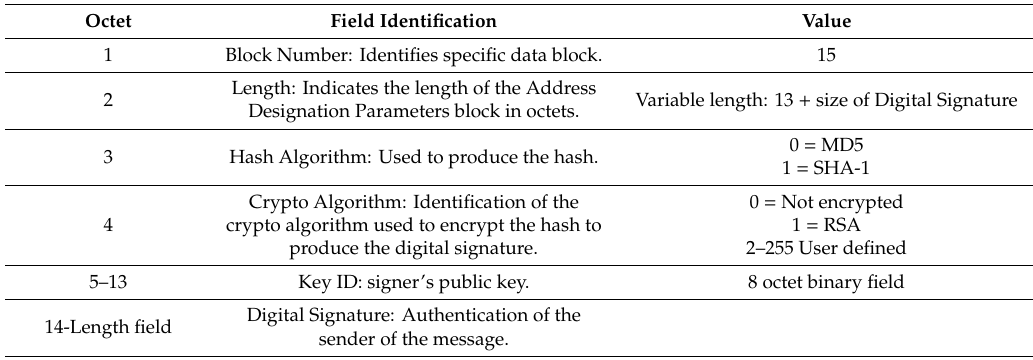
Table 3. Digital